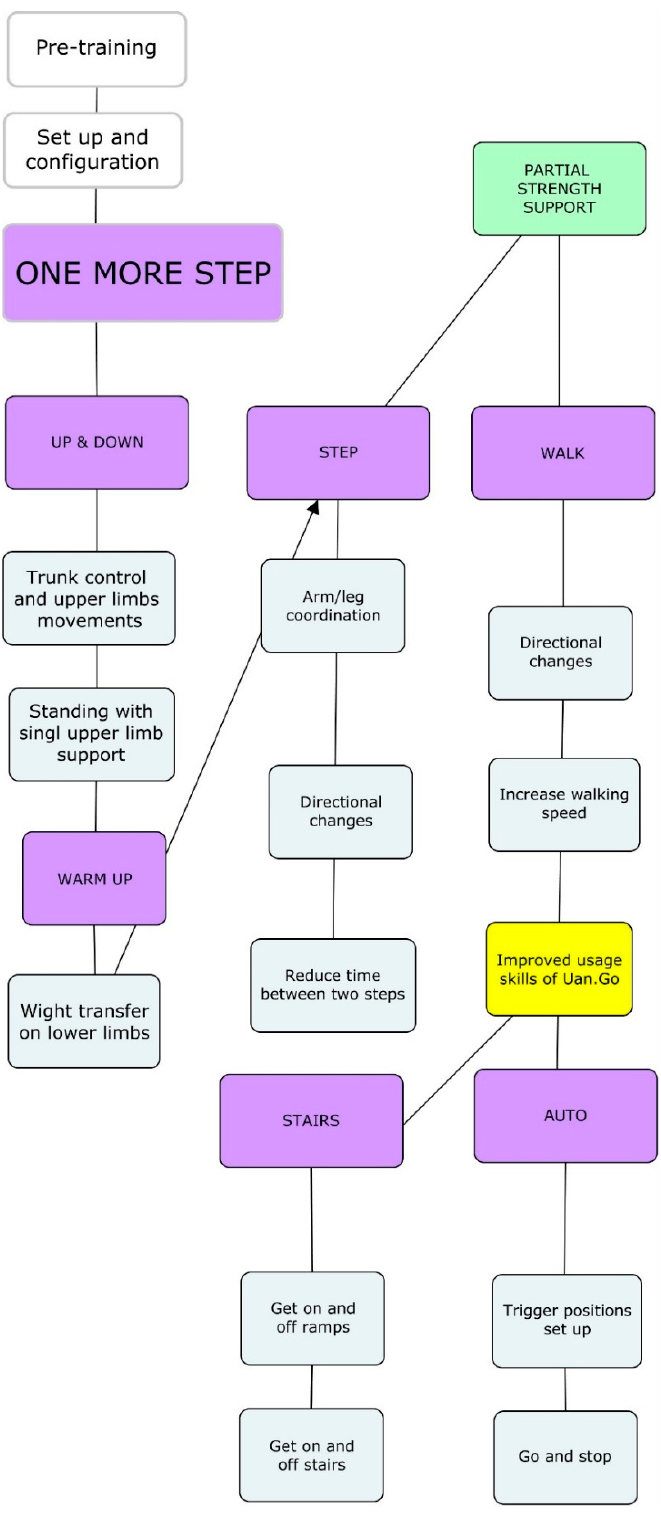
Figure 2. ONE MORE STEP is the treatment protocol developed for this study.